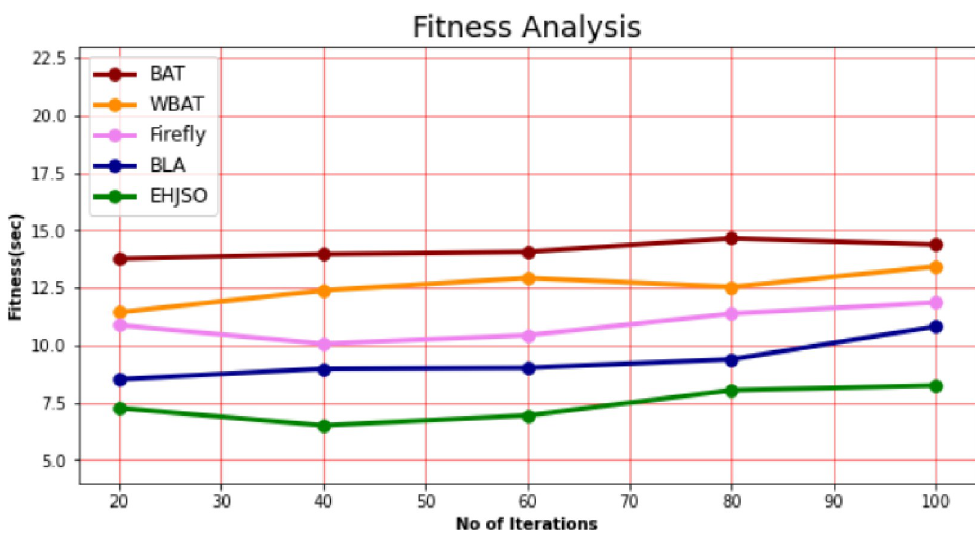
Fig 6. Fitness analysis for EHJSO method with existing system.